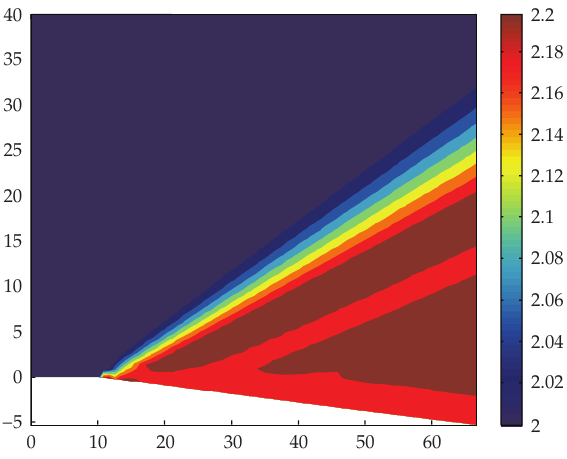
Figure 7: Numerical solution of the expansion